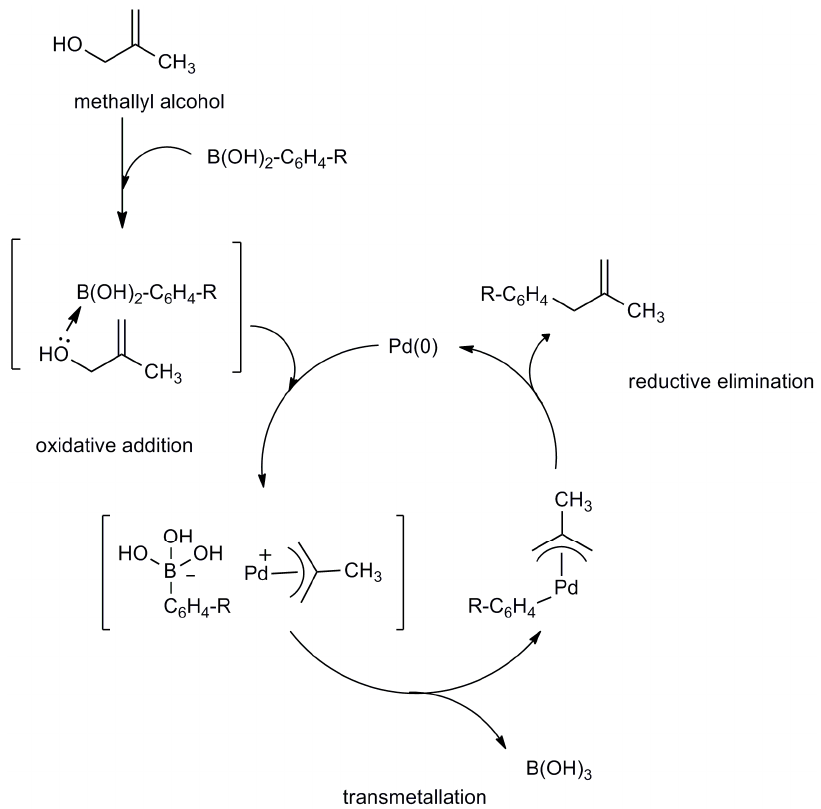
Figure 2. Plausible catalytic cycle mechanism.